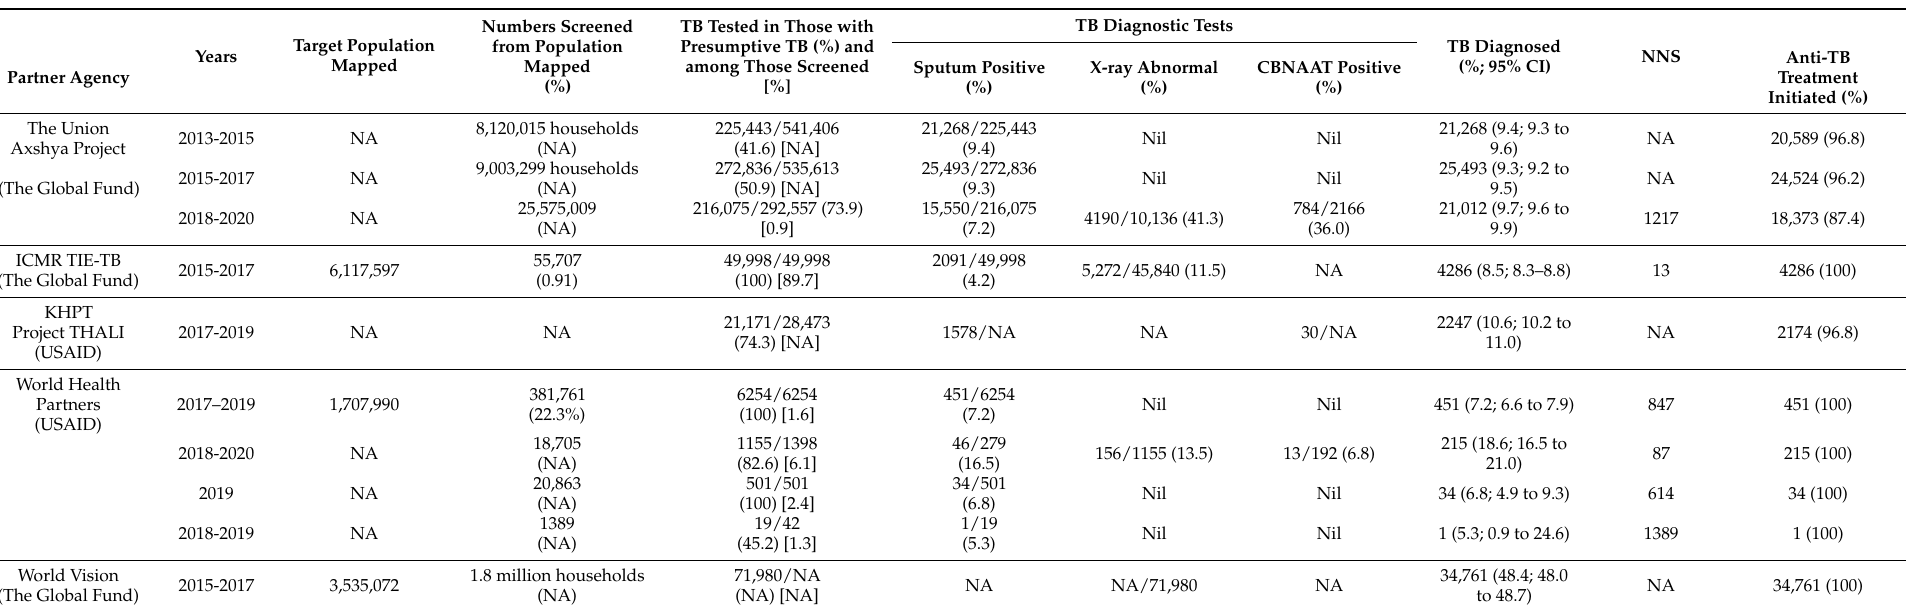
Table 3. Activities and outcomes of the active case finding (ACF) conducted by implementing partner